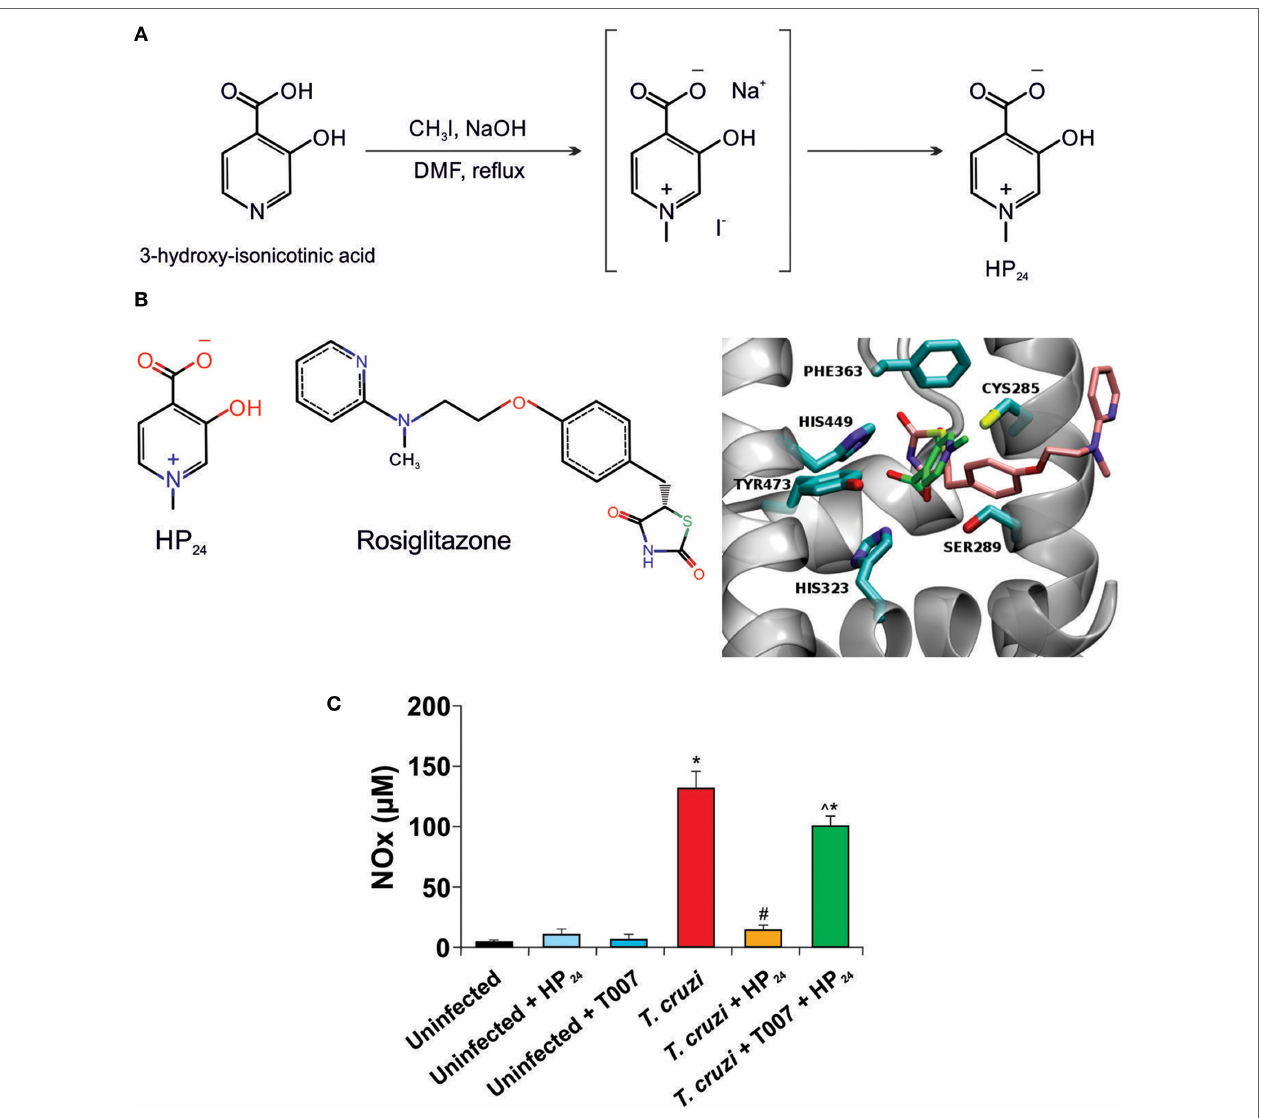
FigUre 1 | HP 24 interacts with peroxisome proliferator-activated receptor gamma (PPAR γ ). (a) Route for HP 24 synthesis. (B) Predicted binding mode for HP 24 to PPAR γ . On the right panel, we show rosiglitazone (RSG) from complex crystallographic structure (PDB id 2PRG) superimposed to most probably conformation of HP 24 compound from docking calculations. RSG, HP 24 , and receptor binding site amino acids are shown in stick representation, colored by atom type (oxygen, nitrogen, sulfur in red, blue, and yellow, respectively) except carbons, which are colored in pink, green, and cyan respectively. Receptor backbone is shown in gray with New Ribbon representation. On the left panel, we show chemical formula of RSG and HP 24 . The images were generated using VMD software (24). (c) Peritoneal macrophages from Trypanosoma cruzi -infected mice were preincubated with T0070907 (50 µM), a PPAR γ specific antagonist, for 30 min. Then, incubated with HP 24 (100 µM). After 48 h, nitrite accumulation was measured in the cultured medium. For panel (c) , results represent the mean ± SEM of three independent experiments (five mice per group). * P < 0.05 vs. uninfected cells, # P < 0.05 vs. T. cruzi -infected cells. ^ P < 0.05 vs. T. cruzi- infected HP 24 -treated